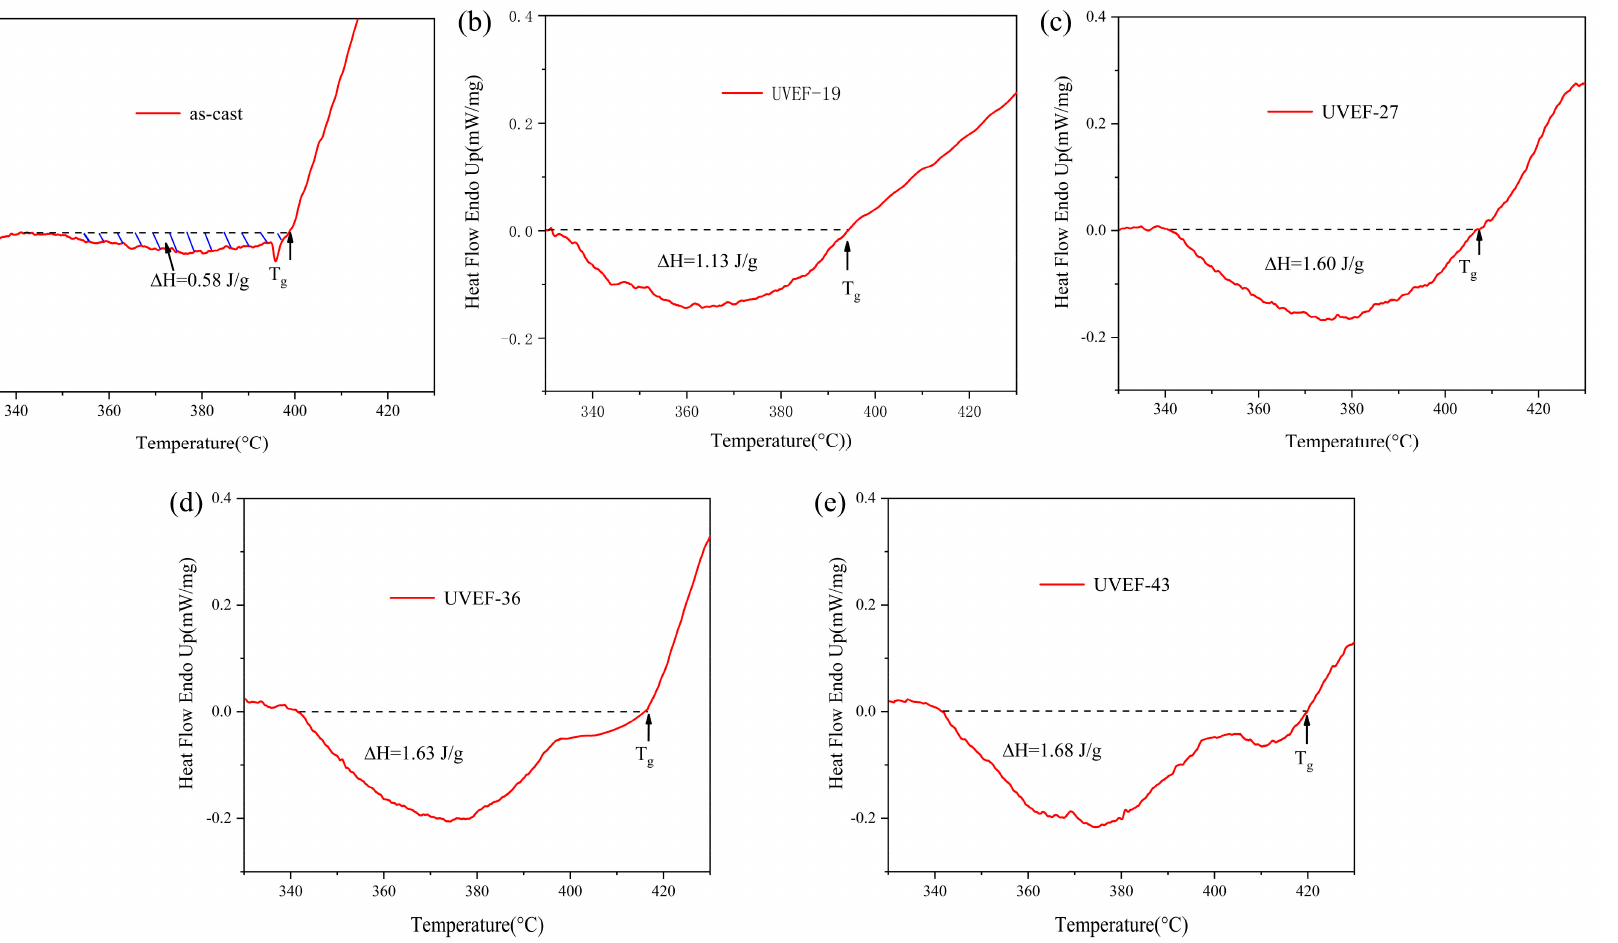
Figure 5. Relaxation enthalpy Δ H of the as ‐ cast and UVEF ‐ treated samples ( a ) as ‐ cast; ( b ) UVEF ‐ 19; ( c ) UVEF ‐ 27; ( d ) UVEF ‐ 36; and ( e ) UVEF ‐ 43.